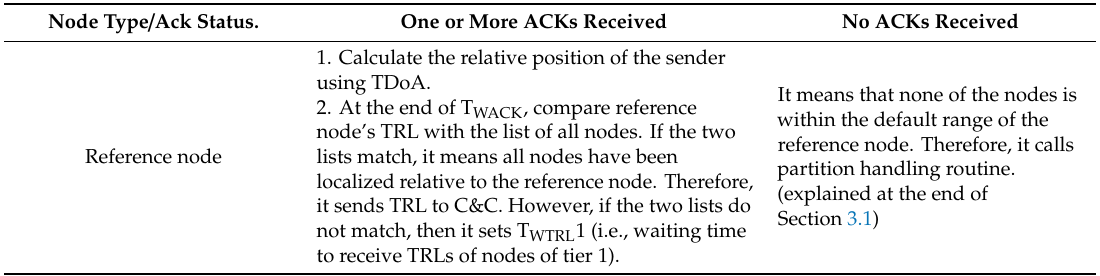
Table 1. Actions during and at the end of T WACK .